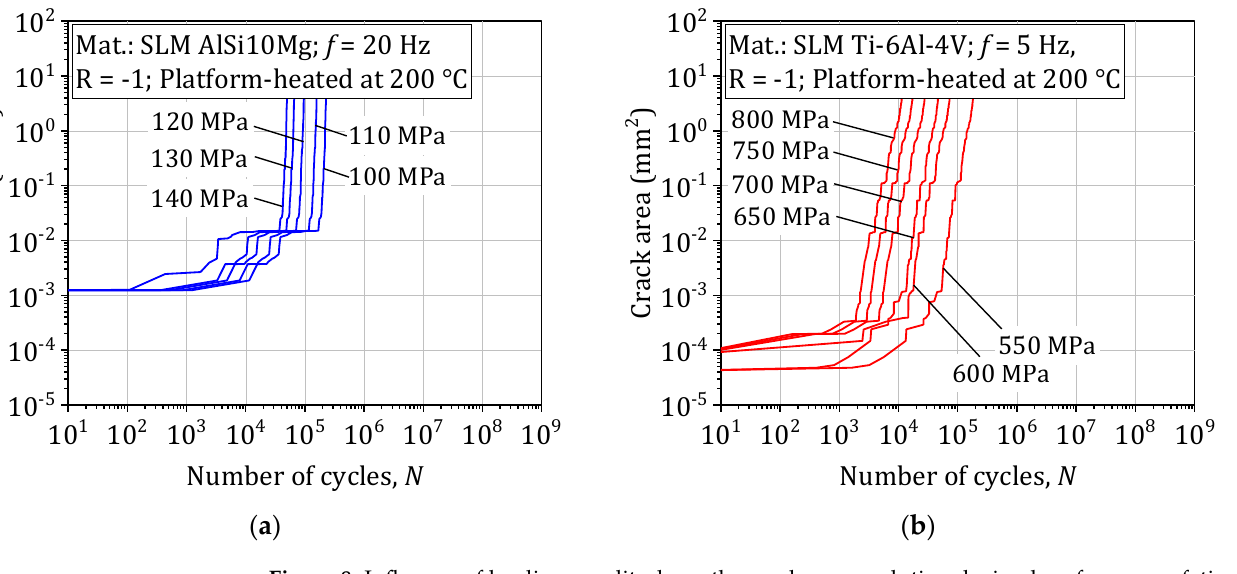
( b ) Figure 9. At 20 kHz, the loading amplitude has a significant impact on the propagation of cracks: ( a ) AlSi10Mg and ( b ) Ti-6Al-4V are available. In Figures 10 and 11, the crack propagation curves are represented as a relationship between the development rate in the cross-sectional damaged area and the macroscopic stress intensity factor. The stress intensity factor is calculated according to the relation ∆𝐾 = 2 𝜋 𝜎(cid:3495)𝜋√𝑎𝑟𝑒𝑎 (17) where ∆𝐾 is the stress intensity factor in mode I and 𝜎 is the effective stress. It is based on the stress intensity factor formulations for a penny-shaped crack which can be found in [29]. It could be observed in the case of AlSi10Mg that ∆𝐾 is unstable in the region of